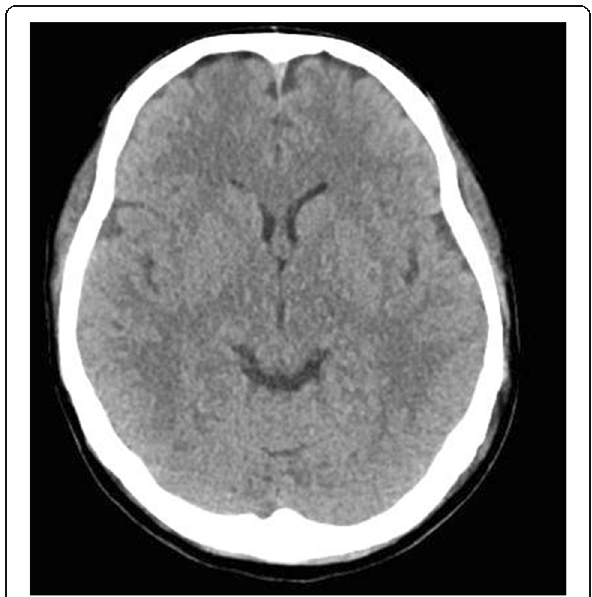
Fig. 3 Head computed tomography immediately after the seizure attack. The image demonstrates mild cerebral edema 7 h